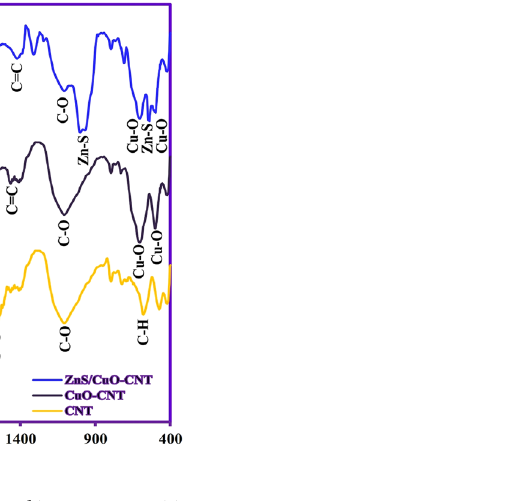
Figure 6. FTIR spectra of CNT, CuO-CNT, and